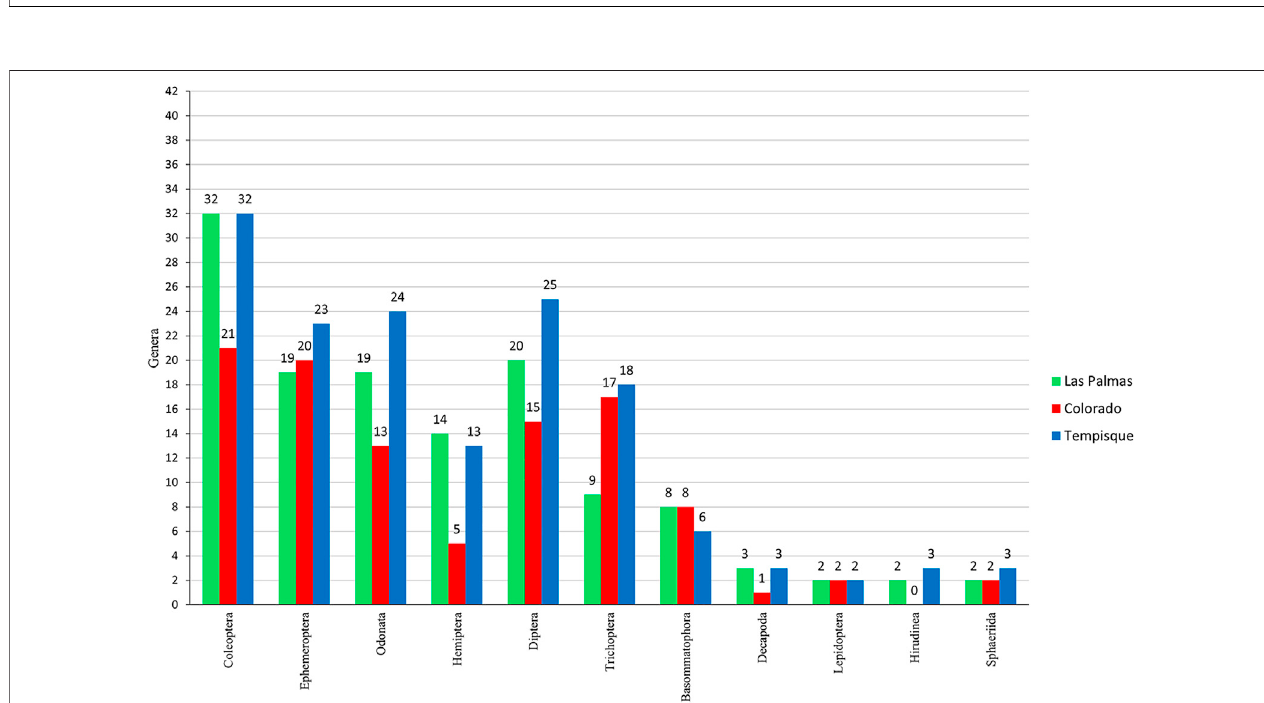
FIGURE 6 | Bar-graph is indicating the number of genera per order collected in the three river